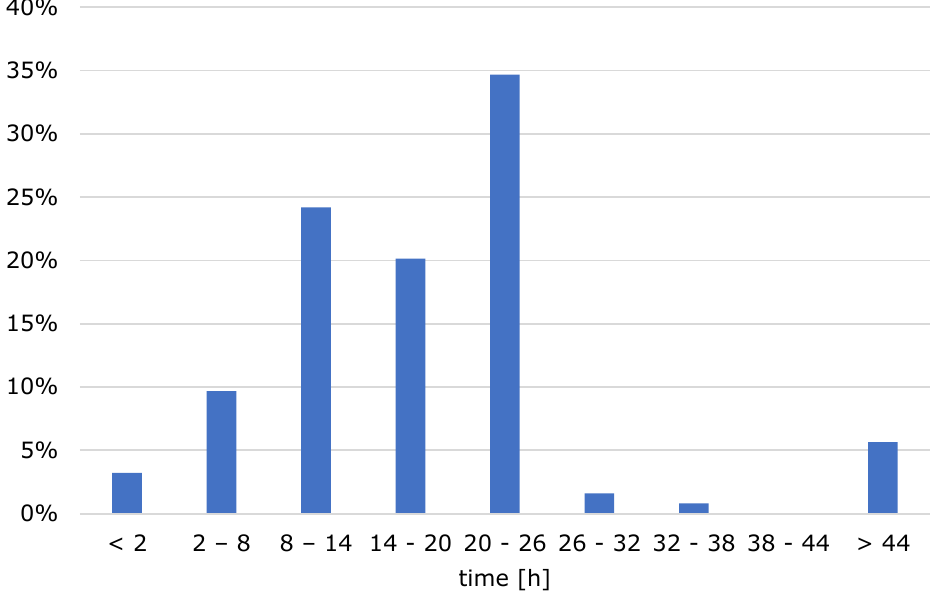
Figure 2. Extraction temperature of cold brew coffee.